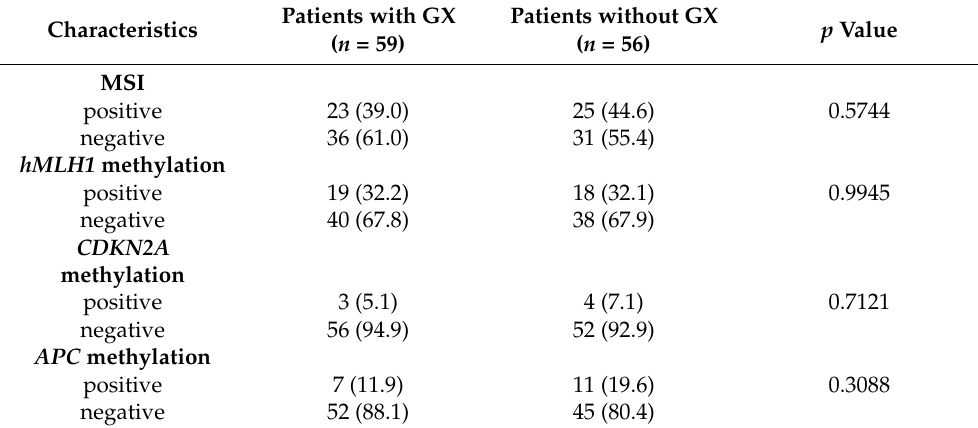
Table 3. Relationship between gastric xanthelasma and genetic alterations in early gastric cancer